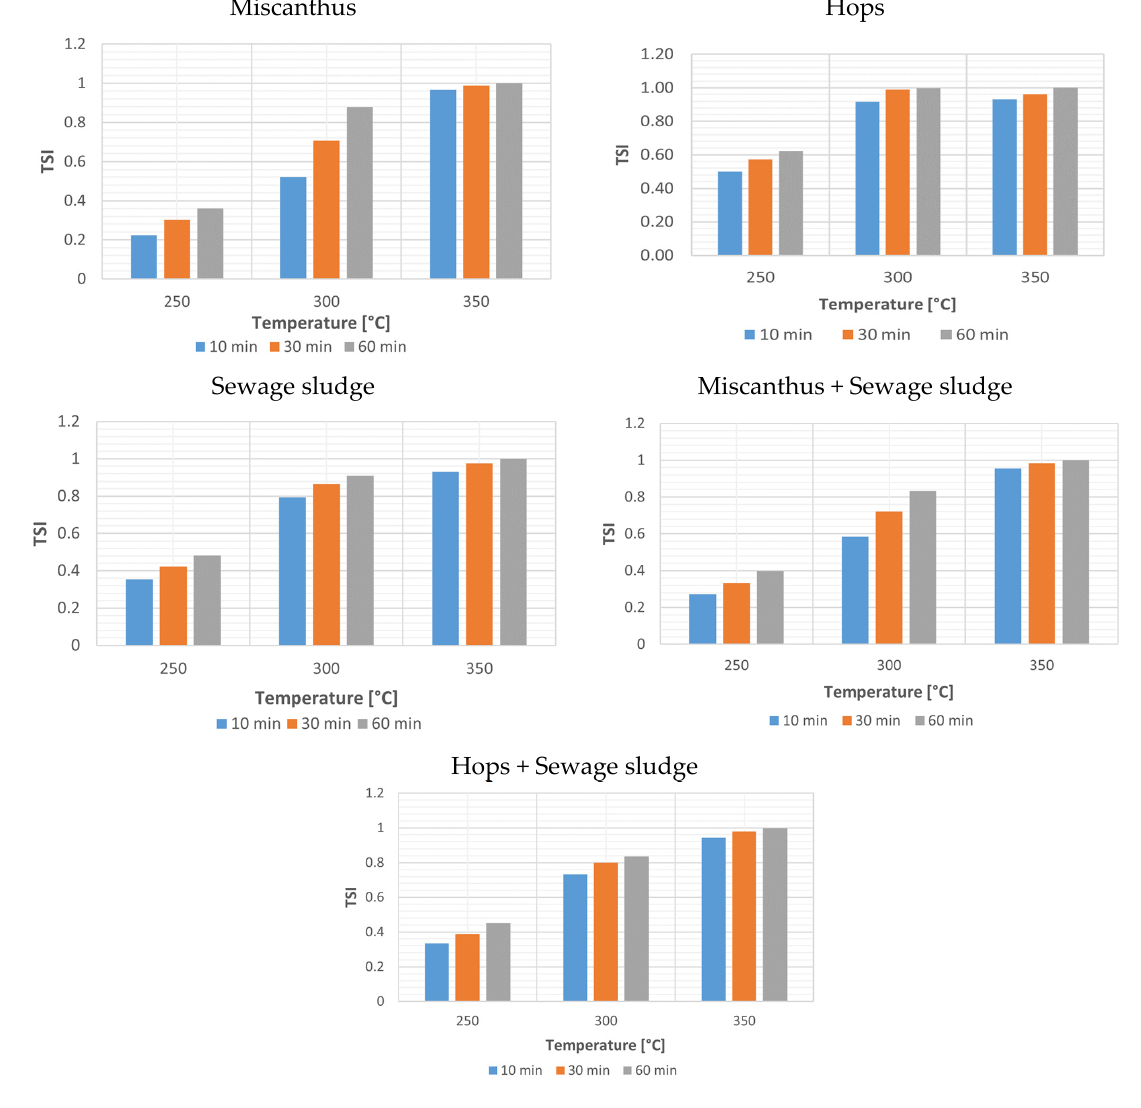
Figure 4. TSI with respect to torrefaction temperature and time for all five materials. In addition, the same was stated for the correlation between TSI and energy yield, which is presented in Figure